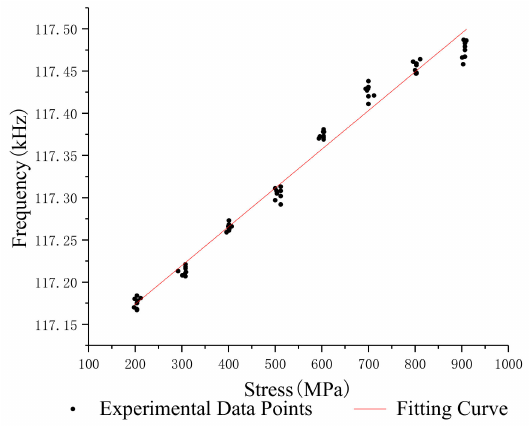
Figure 11. Curve—15